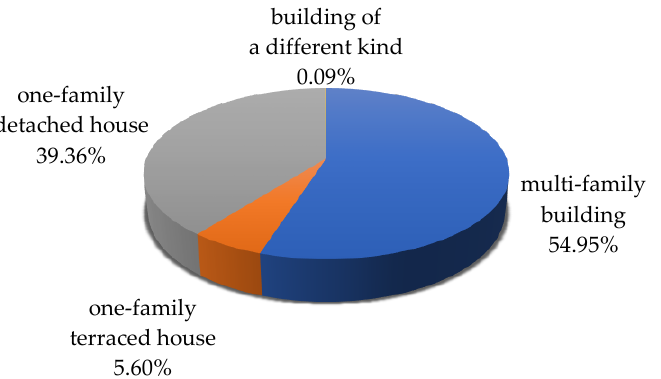
Figure 1. Structure of residential buildings in Poland in 2020 divided according to their types. Own research based on Central Statistical Office [56].